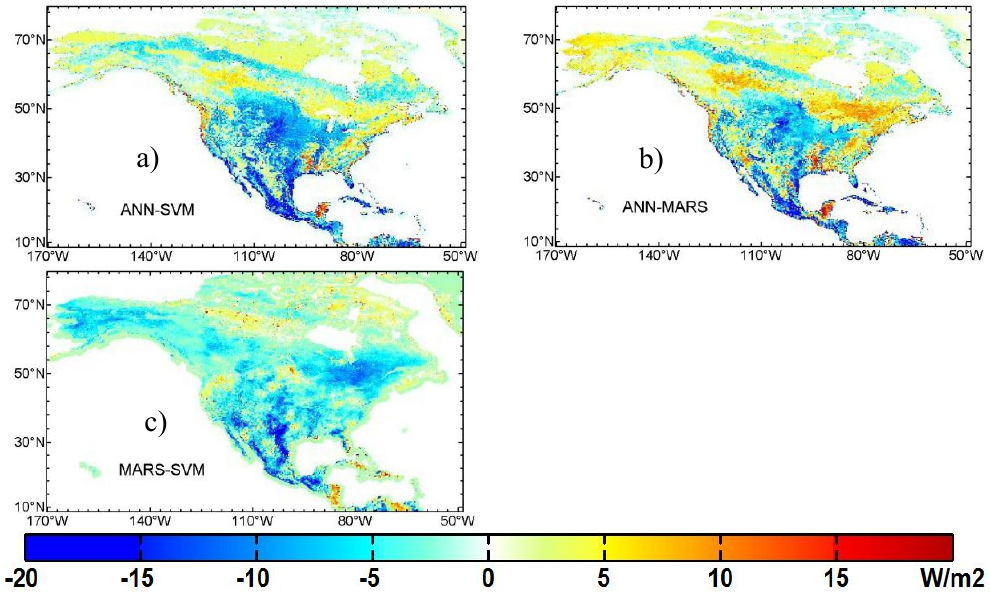
Figure 11. Spatial differences in the average annual terrestrial LE (2002–2004) between three machine learning algorithms.